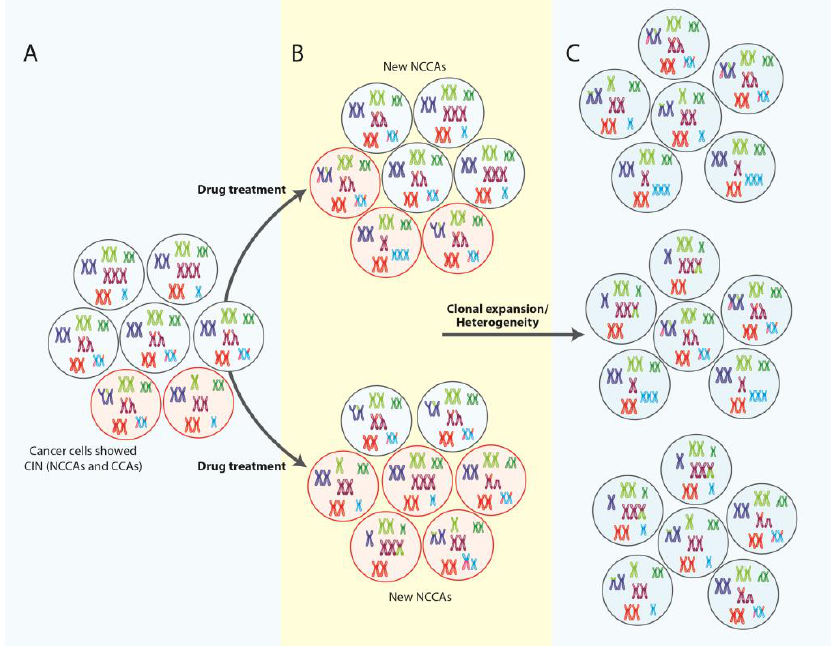
Figure 3. Role of CIN in cancer evolution and therapy response. ( A ) CIN, including both clonal (black circles) and NCCAs (red circles), could impact cell responses to drug treatments. NCCAs can lead to variable drug sensitivity, promoting the survival of a fraction of the tumor cell population. ( B ) The administration of high-dose chemotherapeutics can result in the generation of new NCCAs (red circles), ultimately giving the disease a chance for recovery and resistance. ( C ) CIN can conduce to clonal expansion of NCCAs and thus to an overall increase in heterogeneity, favoring cell survival and therapy resistance. Chromosomes with two colors indicate the presence of structural alterations (translocations).